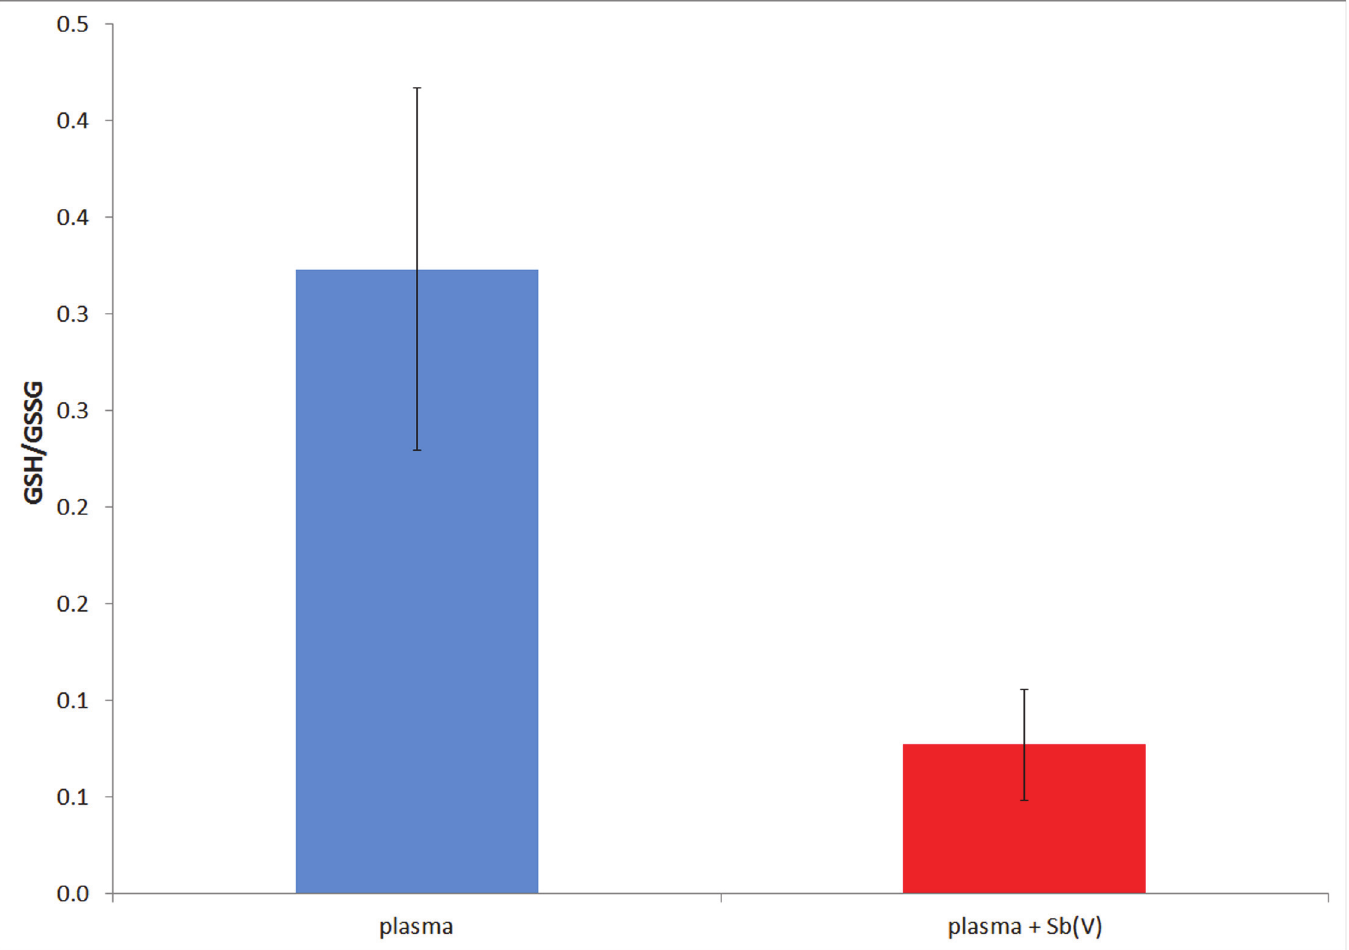
Figure 4. Effect of Sb(V) on the ratio of GSH/GSSG in human blood plasma. The error bars represent the standard deviations from 3 independent assays. t tests to compare data sets at 95% confidence, showed that difference is statistically significant, (t exp = 4.3; t critical; 1 tail, 4 DF = 2.1).